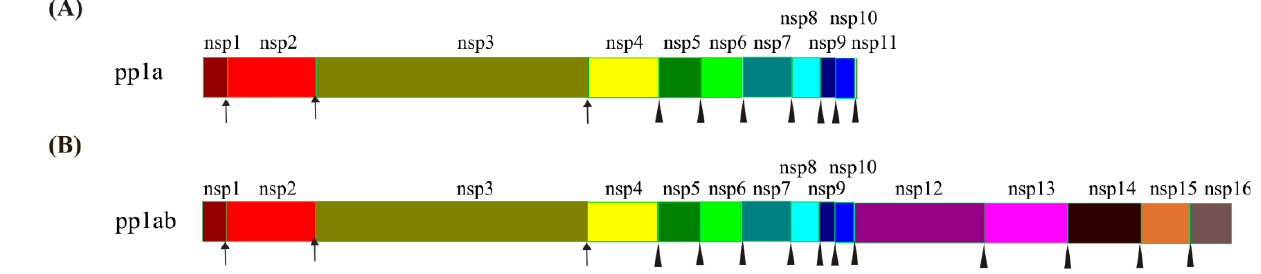
Figure 2. Cleavage of pp1a and pp1ab by PLpro and Mpro. ( A ) Composition and cleavage of pp1a. ( B ) Composition and cleavage of pp1ab. Arrows represent the cleavages by PLpro, and triangles represent the cleavages by Mpro. The polyprotein pp1a is cleaved by PLpro and Mpro into 11 non-structural proteins (nsps) after its synthesis at their respective sites. The pp1ab is synthesized by translating the ORF1ab with the programmed − 1 ribosomal frameshift ( − 1 PRF) on nsp11 and cleaved by PLpro and Mpro into 15 nsps. Table 1. The basic description of the nonstructural proteins based on annotation of the GenBank ID NC_045512.2. and with reference to a recent review on SARS-CoV-2 genomic structure